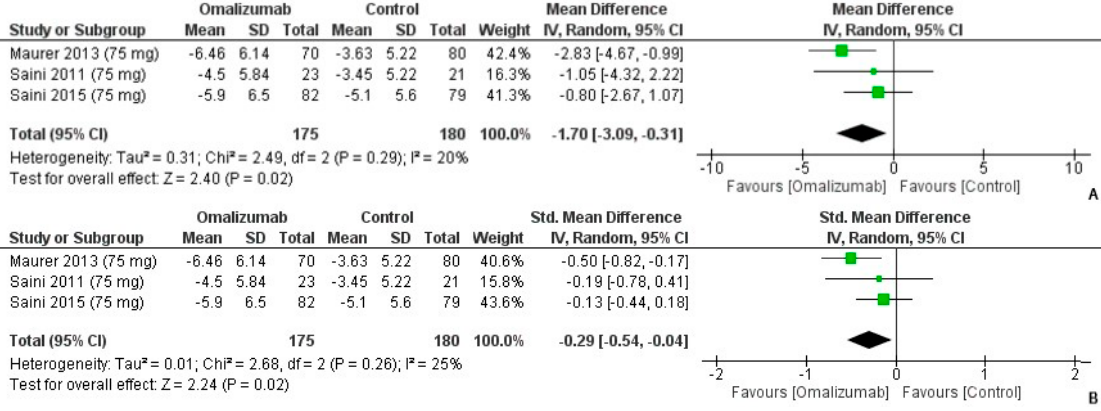
Figure 5. Weekly Wheal Score Outcomes with 75 mg dosage of omalizumab [18,19,23]. ( A ): Mean difference: − 2.36 [95% CI: − 3.77, − 0.94]; Heterogeneity: Tau² = 0.00; Chi² = 0.49, df = 2 ( p = 0.78); I² = 0%; Test for overall effect: Z = 3.25 ( p = 0.001). ( B ): Standardized mean difference: − 0.35 [95% CI: − 0.56, − 0.14]; Heterogeneity: Tau² = 0.00; Chi² = 0.36, df = 2 ( p = 0.84); I² = 0%; Test for overall effect: Z = 3.24 ( p = 0.001). On the reported wheal score outcomes post administration of 150 mg of omalizumab, the mean difference was − 4.51 (95% CI: − 5.94, − 3.08) (Figure 6A). There was no heteroge- neity (I 2 = 0%, p < 0.0001). Cohen’s d had a medium effect size in favor of omalizumab intervention for CU ( − 0.67, 95% CI: − 0.88, − 0.45). Overall, there was no heterogeneity in the analysis (I 2 = 0%, p < 0.0001) (Figure 6B).